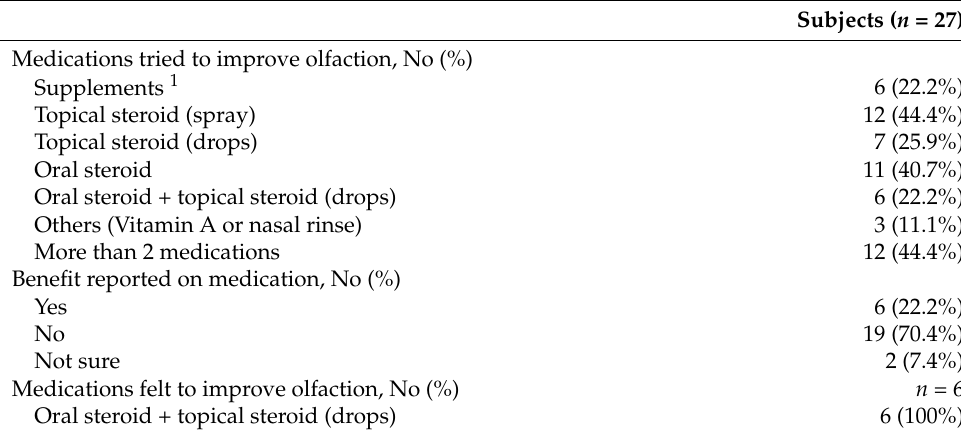
Table 2. Treatments tried excluding OT.